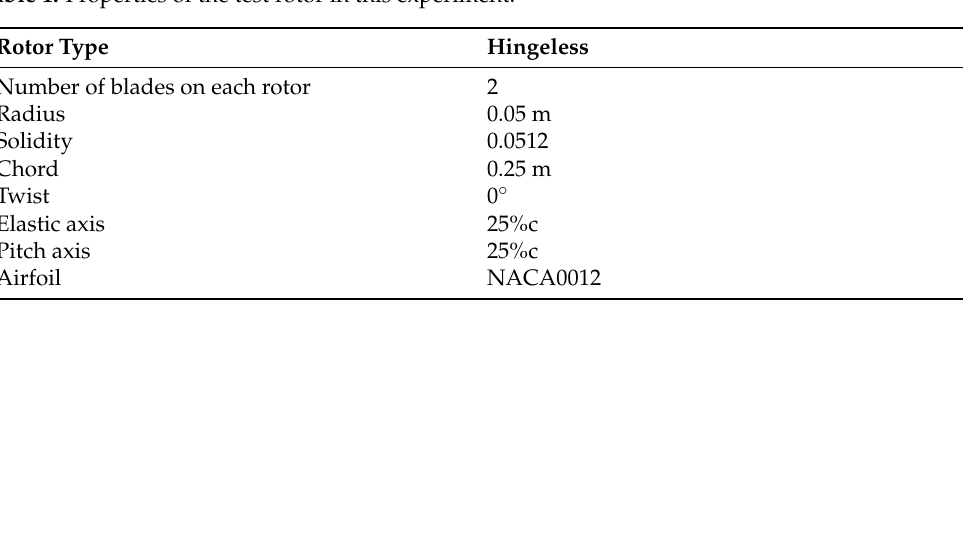
Figure 1. View of the small-scale compound rigid-rotor system and the symmetrical airfoil section. Table 1. Properties of the test rotor in this